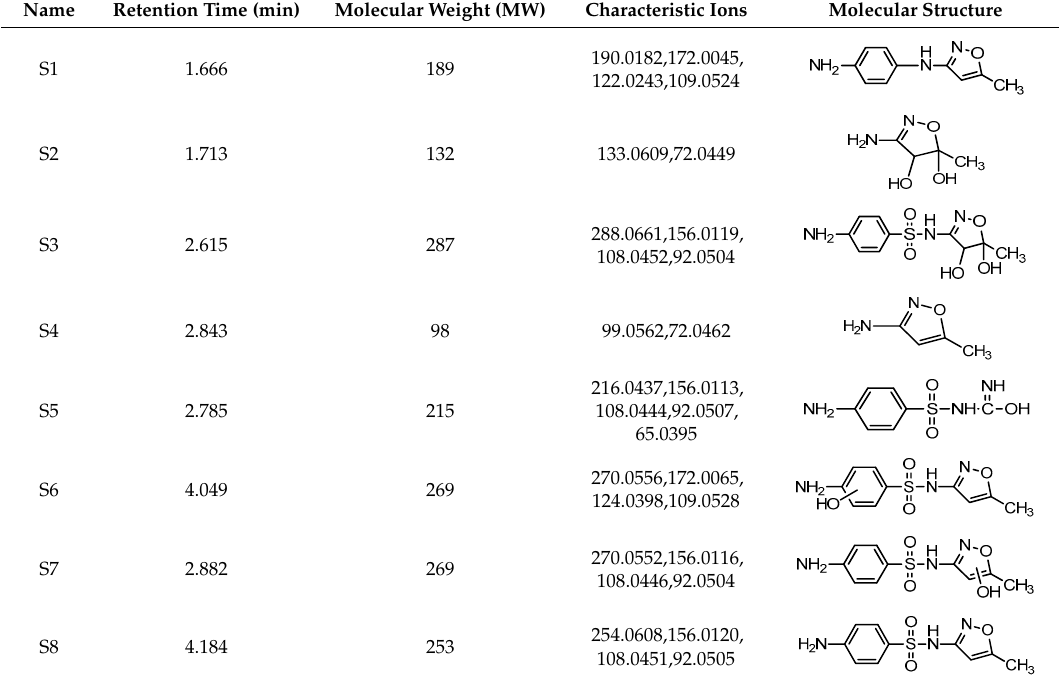
Table 2. The structure of transformation products and their MS fragmentation data in the UV/H 2 O 2 oxidation process of SMZ.